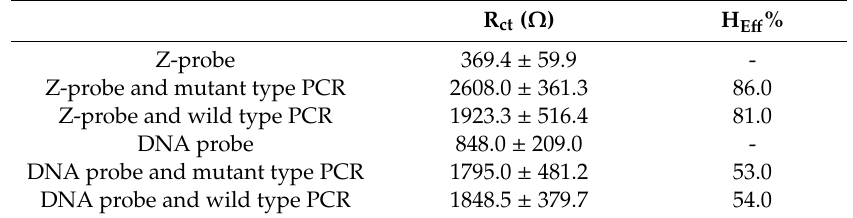
Table 3. The average R ct values measured with the hybrid form of the Z-probe or DNA probe with mutant type PCR or wild type PCR with the values of H E ff